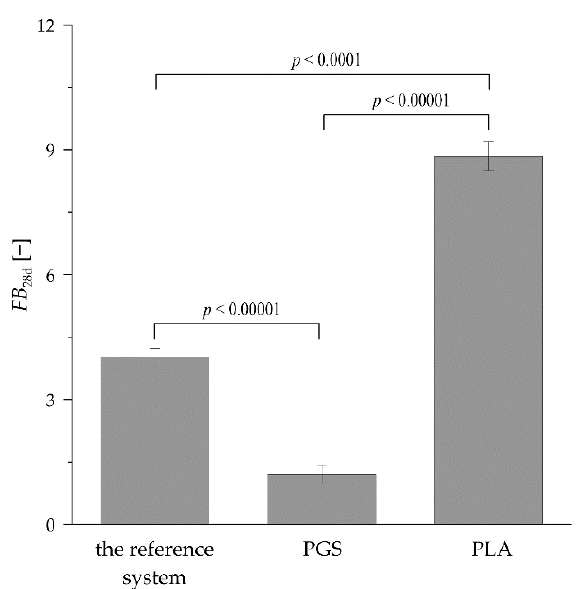
Figure 6. FB 28d values characterize in vitro proliferation of R. graeca hairy roots cultured in the reference system and on organic ester-based scaffolds made of PGS and PLA. The p values over brackets were determined according to the ANOVA test.